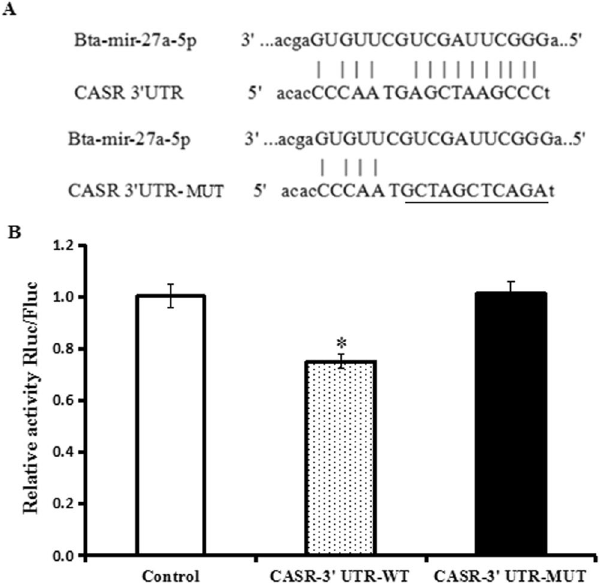
Figure 3. ( A ) Sequence alignment of miR-27a-5p and 3 ′ -UTR of CASR using the TargetScan and miRDB algorithms. ( B ) pmirGLO-CASR -3 ′ UTR-WT or a mutant CASR-3 ′ UTR-MUT was co-transfected into 293 T cells with miR-27a-5p mimics. The assay showed that the luciferase activity in the CASR -3 ′ UTR-WT group was significantly decreased but was increased when compared with the mutant groups. Values are presented as the means ± S.E.M. “ * ”Represents significant differences P < 0.05.